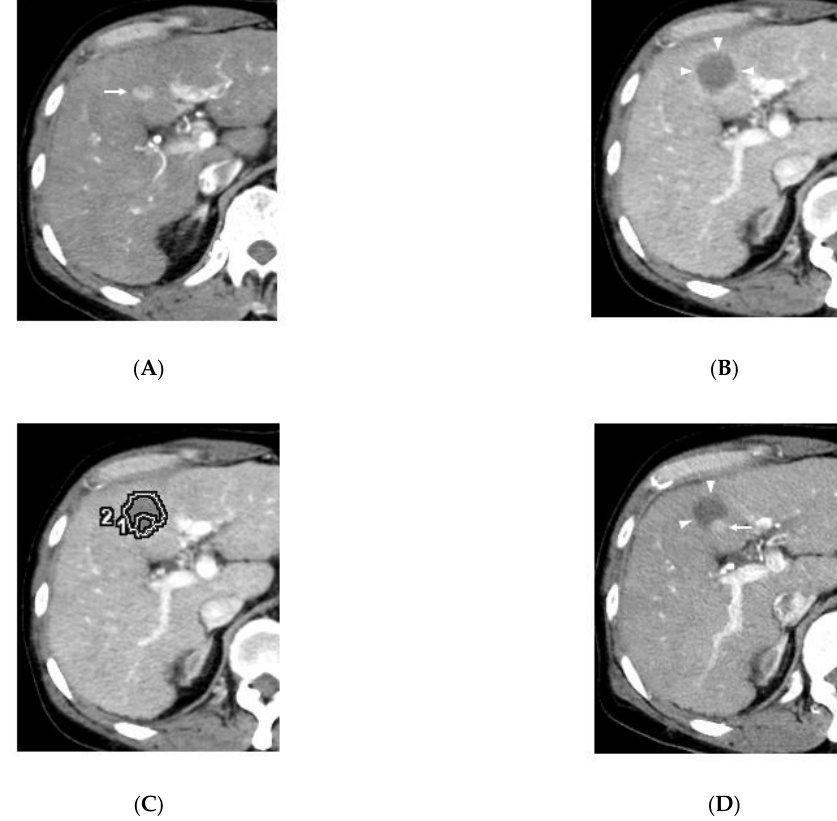
Figure 3. Residual hepatocellular carcinoma after RFA in a 65-year-old man in segment IV of liver. ( A ). Arterial phase CT shows HCC measuring 1.5 cm (arrow) before RFA. ( B ). Low density area due to RFA is extended (arrow heads) on late arterial phase CT, and then, the initial categorization was grade B (relatively curative). ( C ). The tumor border (circle 1) is fused into the image in Figure 2B (post RFA). A part of the tumor is located outside the low density area (circle 2) due to the RFA, meaning incomplete ablation. ( D ). Arterial phase CT obtained six months after the RFA shows an enhancing nodule measuring 1.0 cm (arrow) touching low density areas (arrowheads).